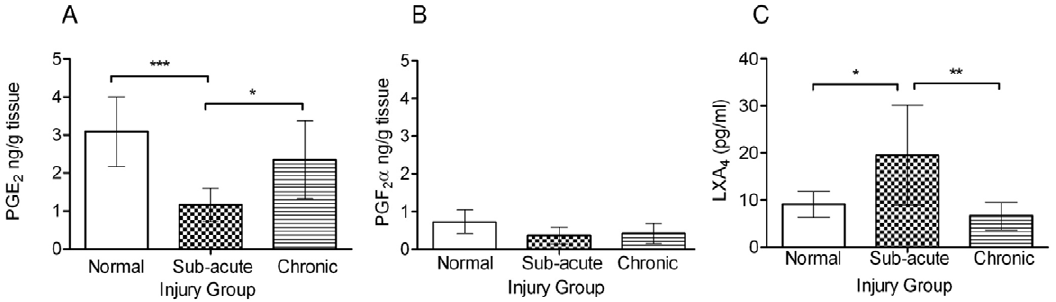
Figure 2. Levels of prostaglandins and lipoxin A 4 in extracts of normal and injured tendons. (A) Mean PGE 2 and (B) mean PGF 2 a levels in normal (n=19), sub-acute (3–6 weeks post injury, n=6) and chronic injured ( . 3 months post injury, n=9) equine superficial digital flexor tendons. PGE 2 levels are significantly reduced in sub-acute injury compared to normal and chronic injuries. In contrast PGF 2 a levels are 3 fold lower than PGE 2 and do not change with injury. (C) Mean LXA 4 levels in normal (n=8), sub-acute (n=7) and chronic (n=6) injured tendons, showing significantly increased levels in sub-acute injury compared to normal and chronic injuries. Error bars denote standard deviation. * P , 0.05, ** P , 0.01, *** P , 0.001.